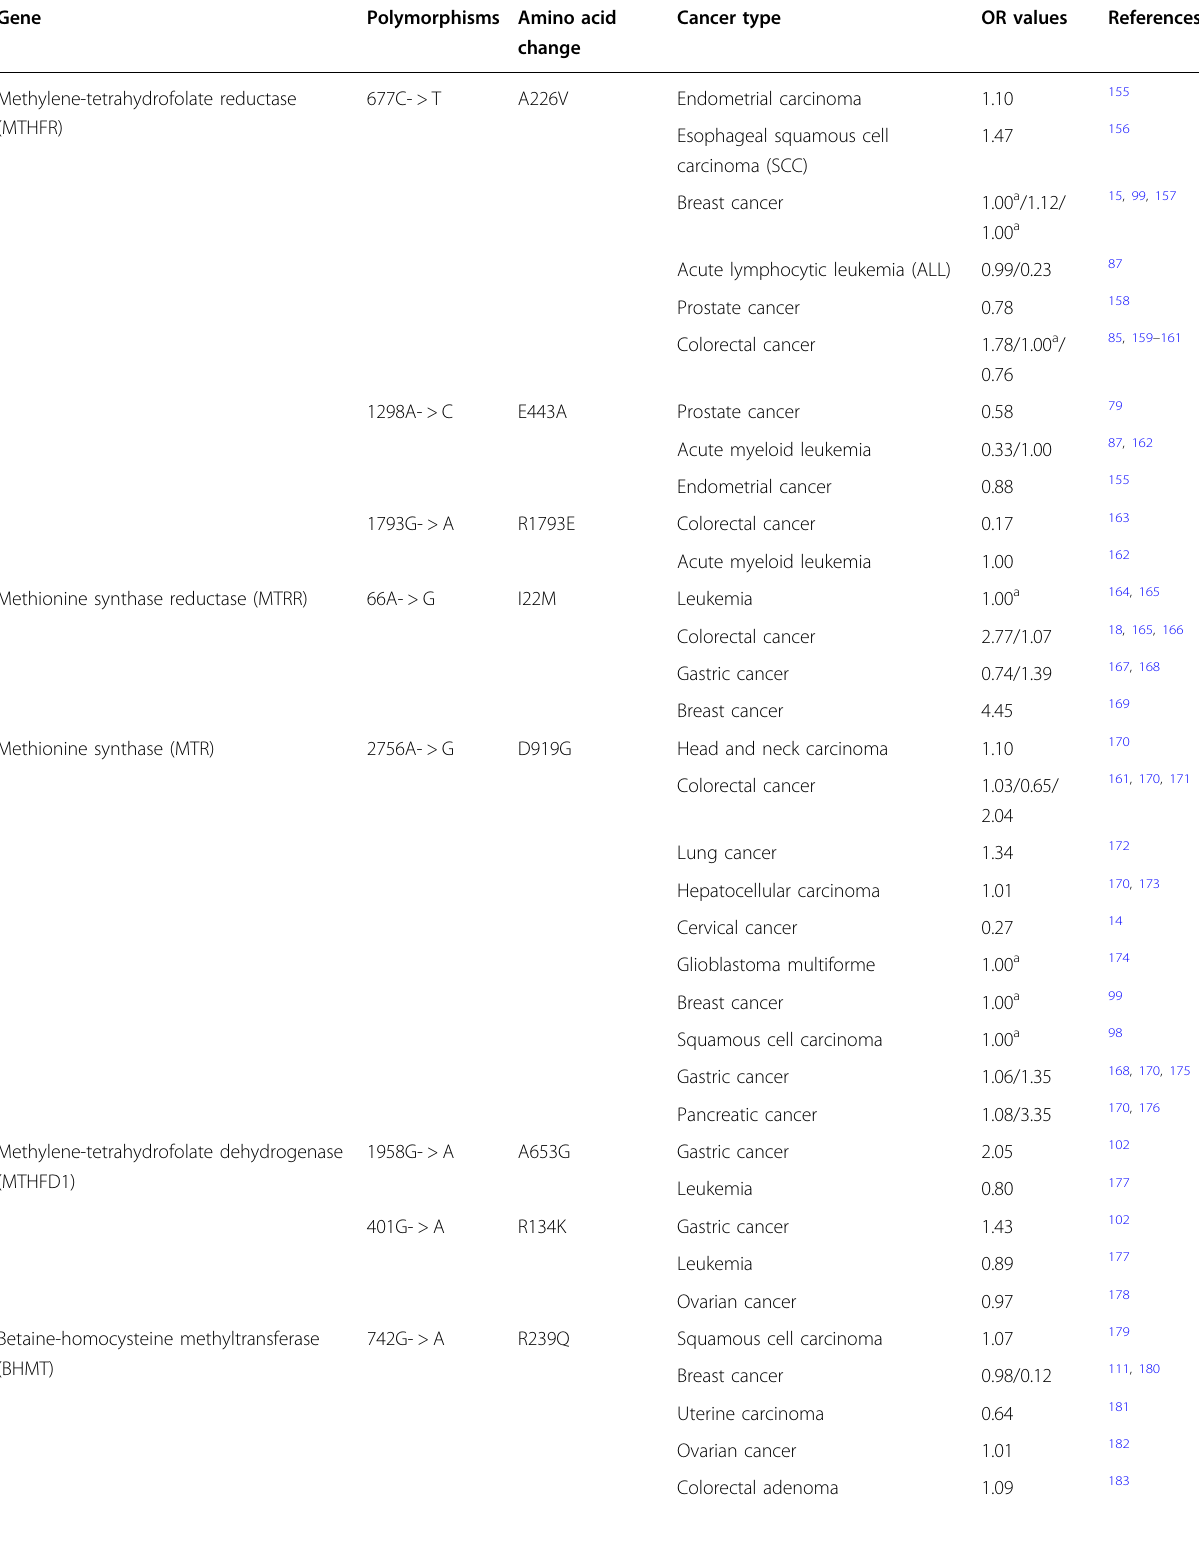
Table 2 Polymorphisms detected in genes involved in homocysteine metabolism